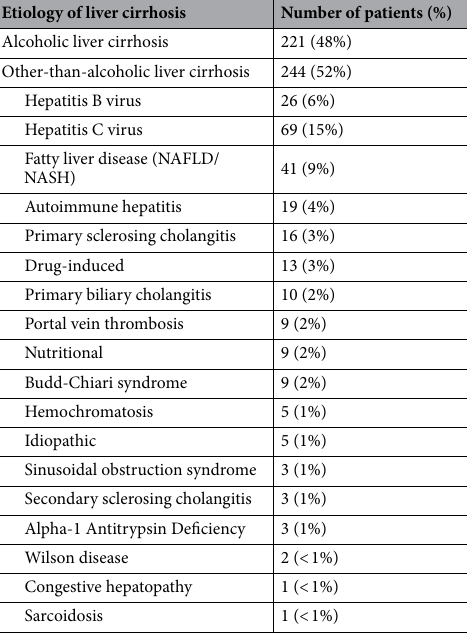
Table 1. Liver cirrhosis etiology. Underlying causes of liver cirrhosis are reported for the entire study population (N = 465) as total numbers as well as percentages of the entire study cohort. NAFLD/NASH non- alcoholic fatty liver disease/non-alcoholic steatohepatitis.